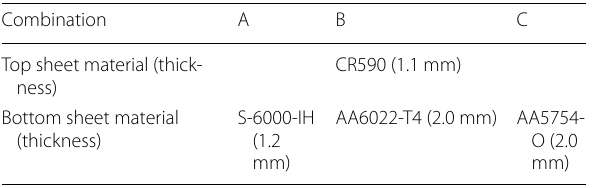
Table 3 Summary of joining combinations for cross-tension strength analysis Combination